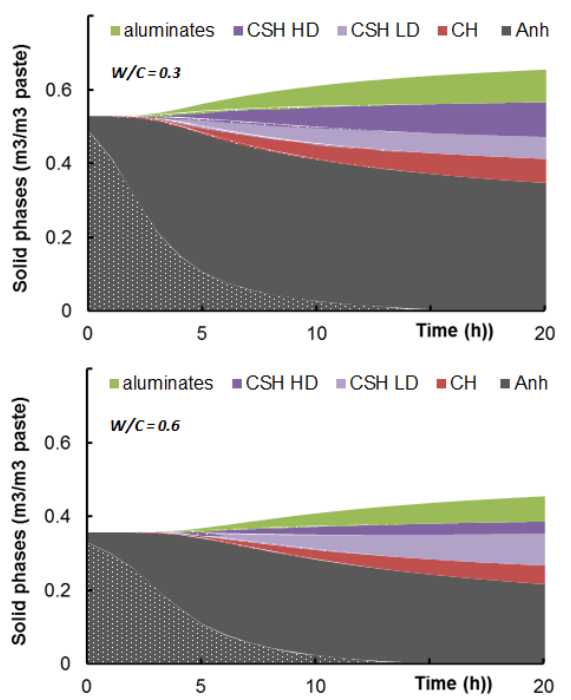
Figure 4. Evolution of percolation of solid paste phases at very early age (shaded areas correspond to the part of the phase that is not percolated).